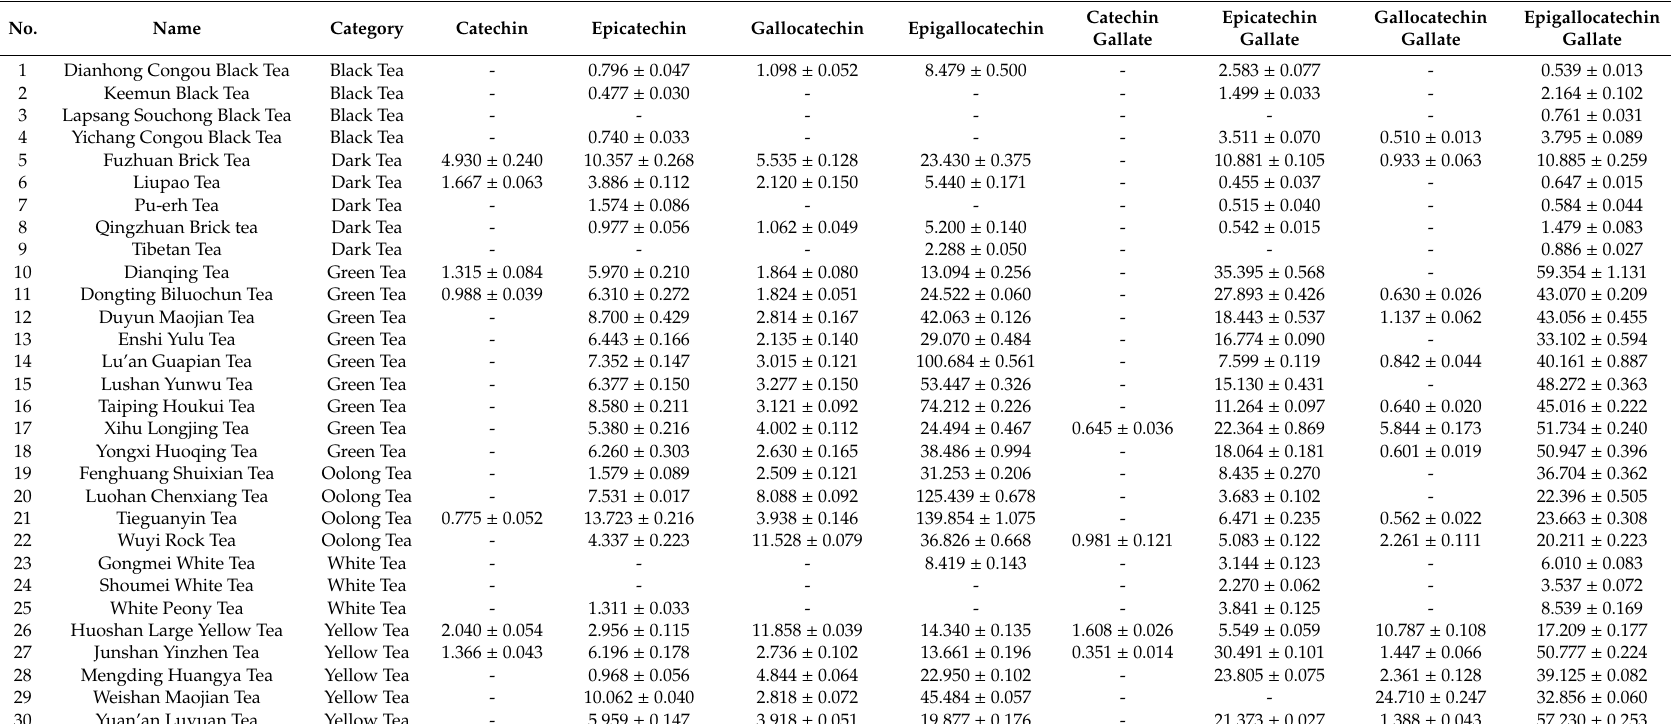
Table 7. The contents (mg / g DW) of catechins in 30 Chinese